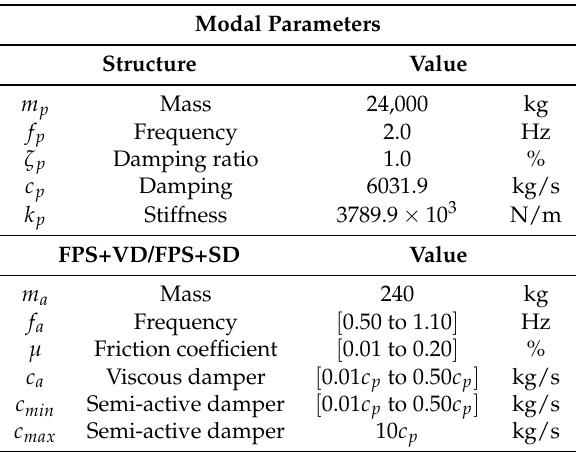
Table 1. Parameters for the sensitivity analysis.